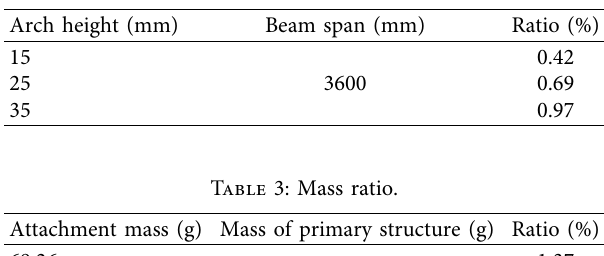
Table 2: Arch-span ratio.